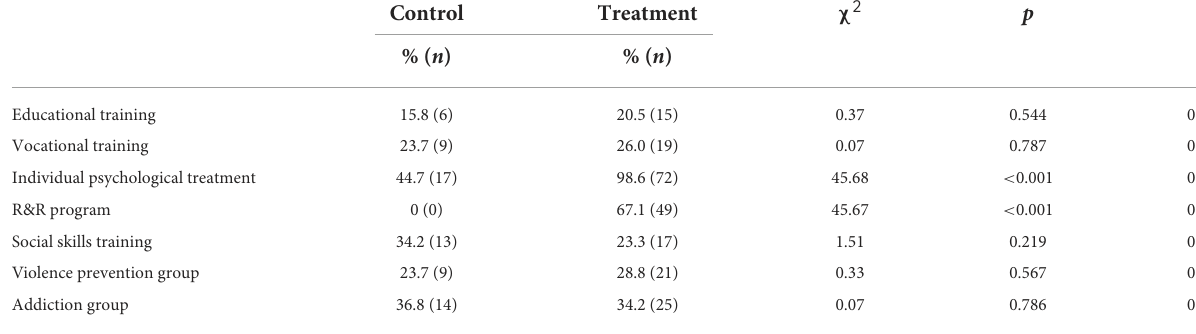
TABLE 2 Intervention and treatment participation in the control ( n = 38) and treatment group ( n = 73). Control